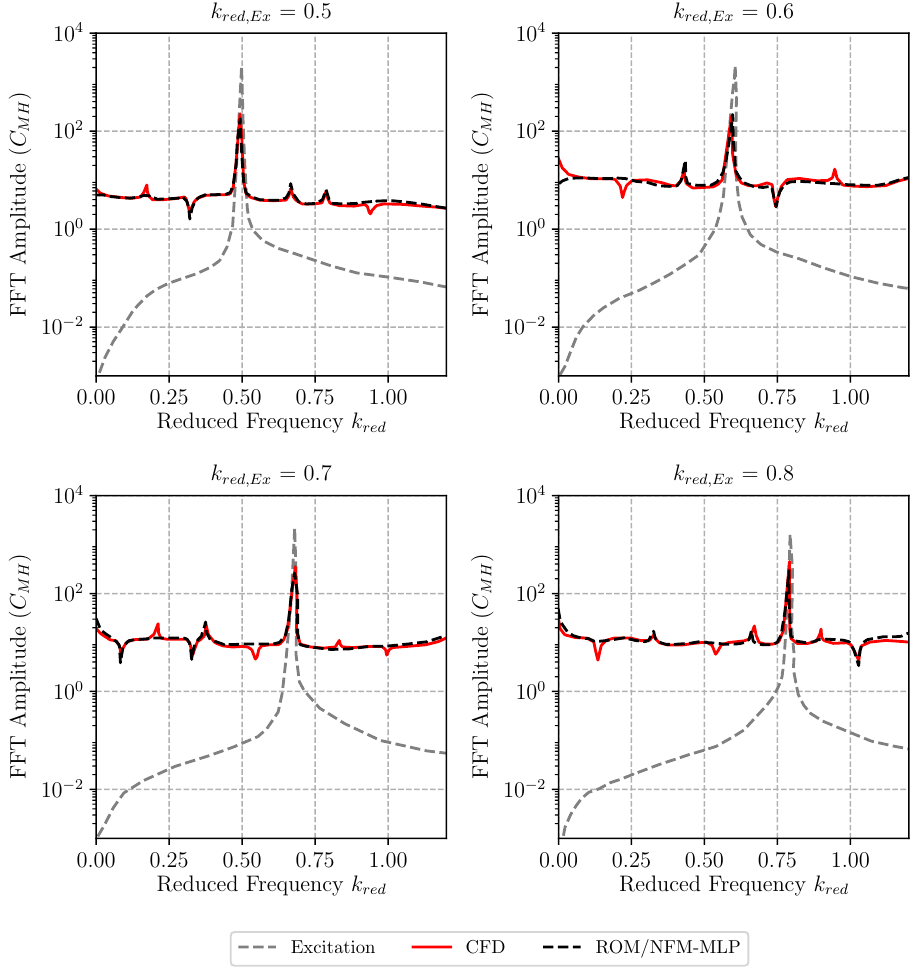
Figure 9. Frequency domain responses of the hinge moment coefficient resulting from harmonic aileron pitching motion with k red , Ex = [0.5, 0.6, 0.7, 0.8]. The results of the NFM-MLP ROM are compared to the reference CFD solution (NACA65 1 213 airfoil, Ma ∞ = 0.82, Re = 20.7 δ min , max = 12/ + 9 ◦ ). −